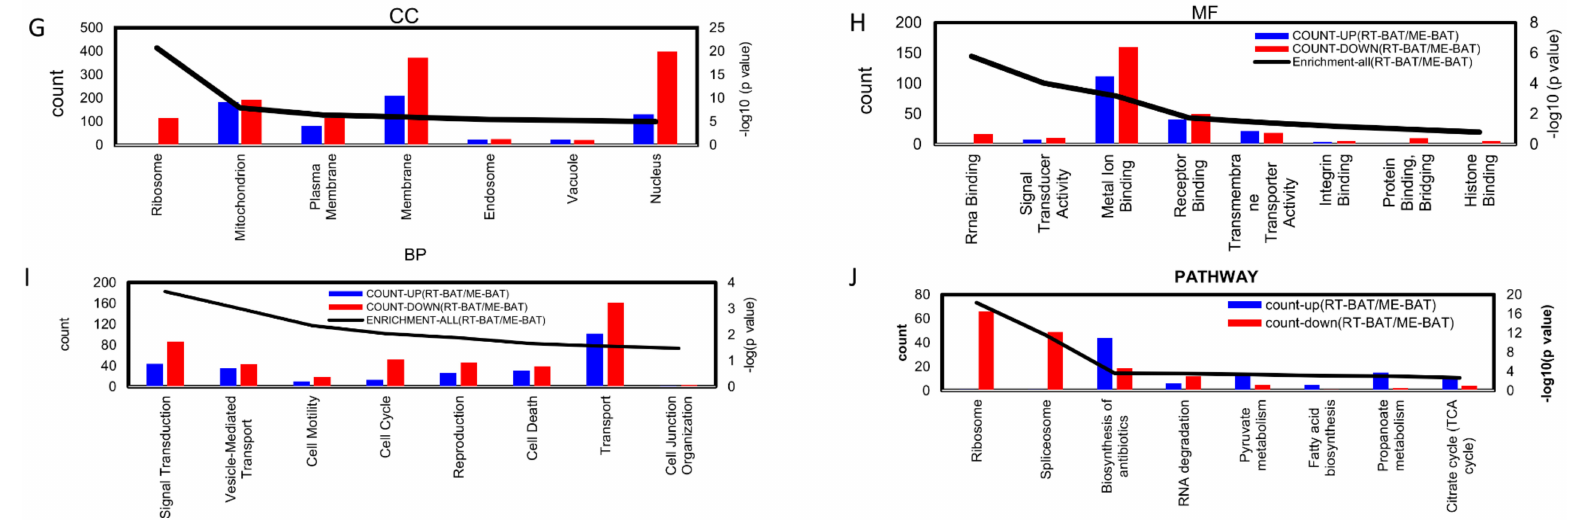
Figure 4. Analysis of proteomics data in neBATs and aBATs. ( A ) Heat map of the total proteins and ( B ) di ff erentially expressed proteins (DEPs) with fold change > 1.5 and p value < 0.05 in neBAT and aBAT. ( C ) Volcano plot of the proteome. The volcano plots show significance on the y-axis ( − log10, p value) against the protein expression ratio (log2, fold change of aBAT vs. neBAT). The FDR cuto ff of < 0.05 is indicated by the blue dashed horizontal lines. The red plots represent upregulation of proteins and the green plots indicate downregulation of proteins. ( D ) Number of proteins upregulated and downregulated in neBATs and aBATs. ( E ) Venn diagrams of neBAT vs. aBAT. ( F ) Principal component analysis (PCA) results are shown in red (neBAT) and blue (aBAT). ( G – I ) GO categories for DEPs in the proteome. ( J ) KEGG pathway analysis of DEPs. Numbers and p -values of DEPs in each